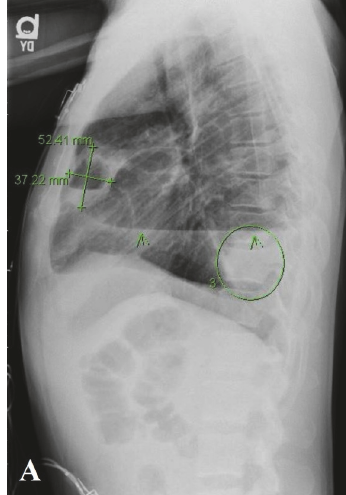
Figure 1: 5.2 x 3.7 cm cavitary lesion containing an air-fluid level. An additional air-fluid level is present along the right lateral hemi- thorax.